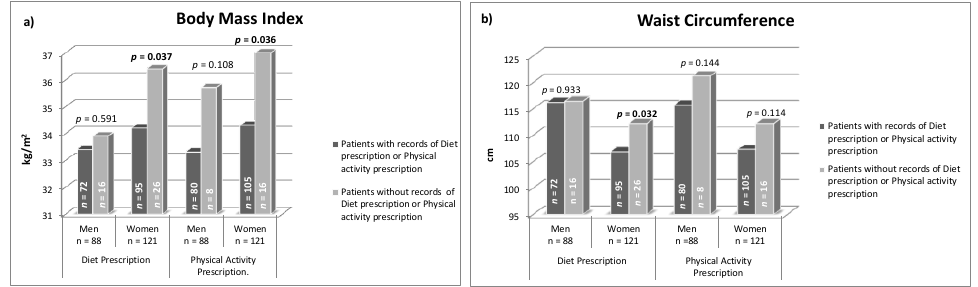
Figure 1. ( a ) Current mean body mass index and ( b ) mean waist circumference in patients with and without records of diet or physical activity prescription, in clinical history.